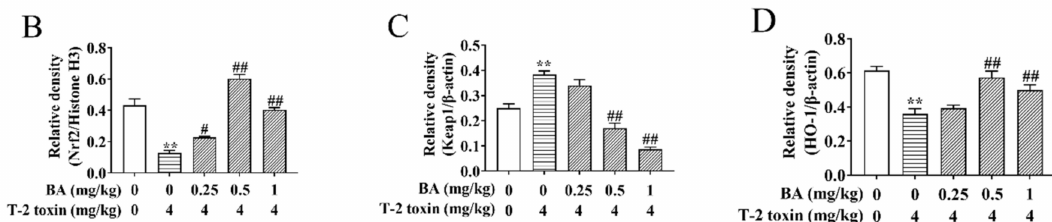
Figure 6. Effects of BA on the relative protein expression of the Nrf2 signaling pathway in the spleen of T-2 toxin-intoxicated mice. The protein expressions of nuclear factor erythroid 2 [NF-E2]-related factor 2 (Nrf2), kelch-like erythroid cell-derived protein with CNC homology [ECH]-associated protein 1 (Keap1), and heme oxygenase-1 (HO-1) were evaluated by Western blot ( A ). Quantitative analysis of Nrf2 ( B ), Keap1 ( C ), and HO-1 ( D ). Data were presented as the mean ± SEM (3 mice per group). ** p < 0.01 vs. the control group. # p < 0.05 and ## p < 0.01 vs. the T-2 toxin